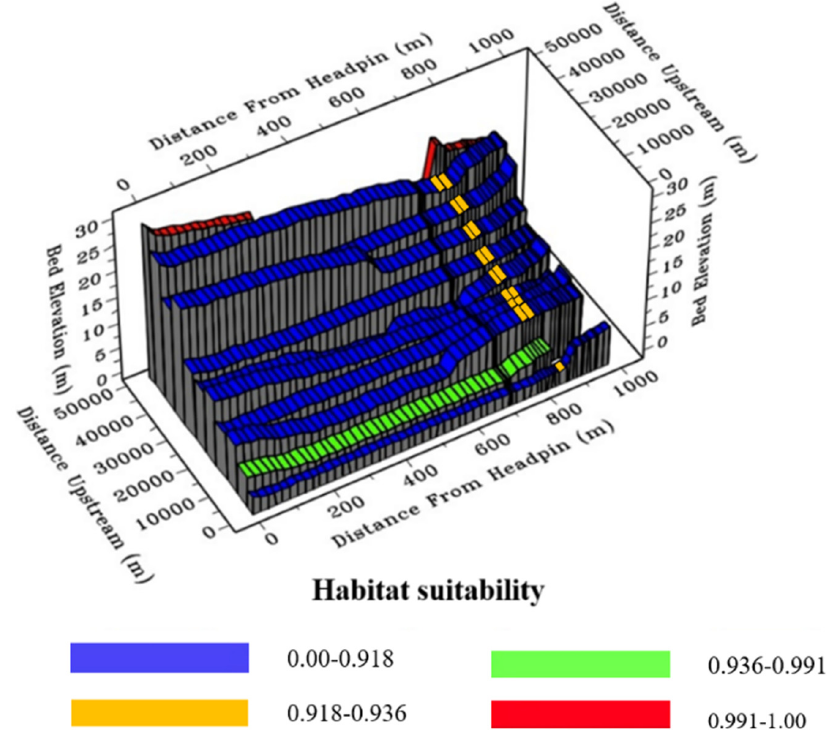
Figure 11. Labeo rohita (Rohu fish) adult life stage 3D habitat plan view.